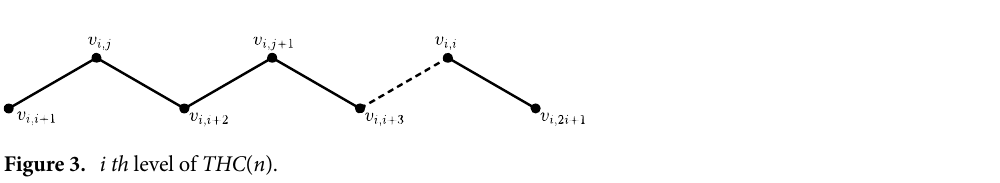
Figure 2. Different Levels of THC ( n ).